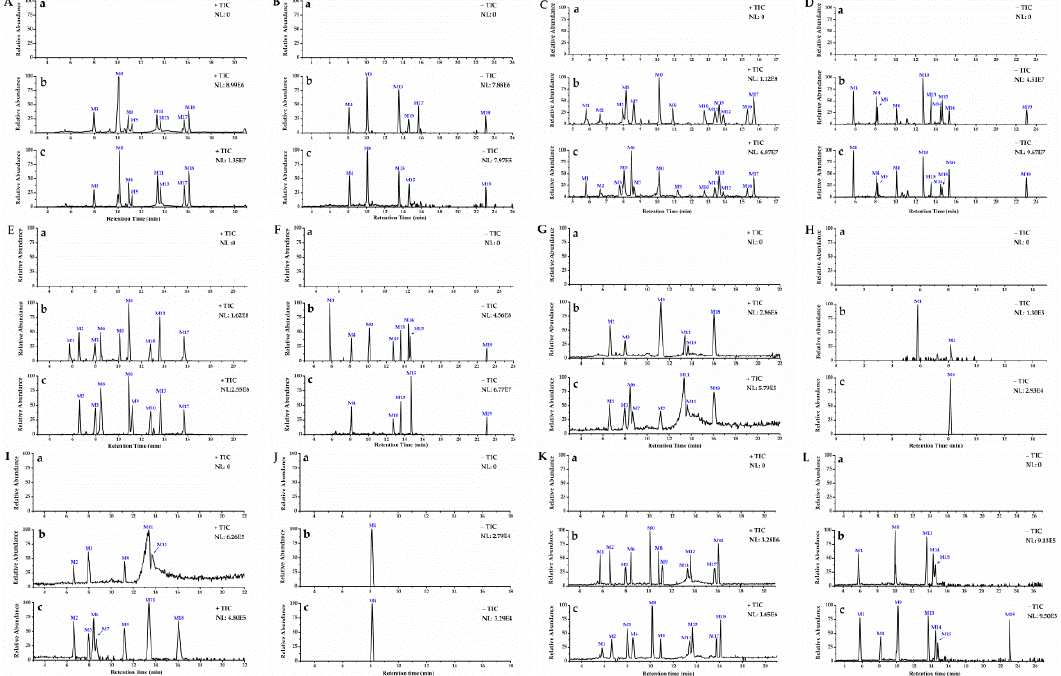
Figure 6. High-resolution TICs of blank group (a), and metabolites in biological samples of sham control group (b) and model group (c). TICs of plasma samples in positive mode ( A ) and negative mode ( B ); urine samples in positive ( C ) and negative mode ( D ); feces samples in positive ( E ) and negative mode ( F ); liver samples in positive ( G ) and negative mode ( H ); kidney samples in positive ( I ) and negative mode ( J ) and brain samples in positive ( K ) and negative mode ( L ).